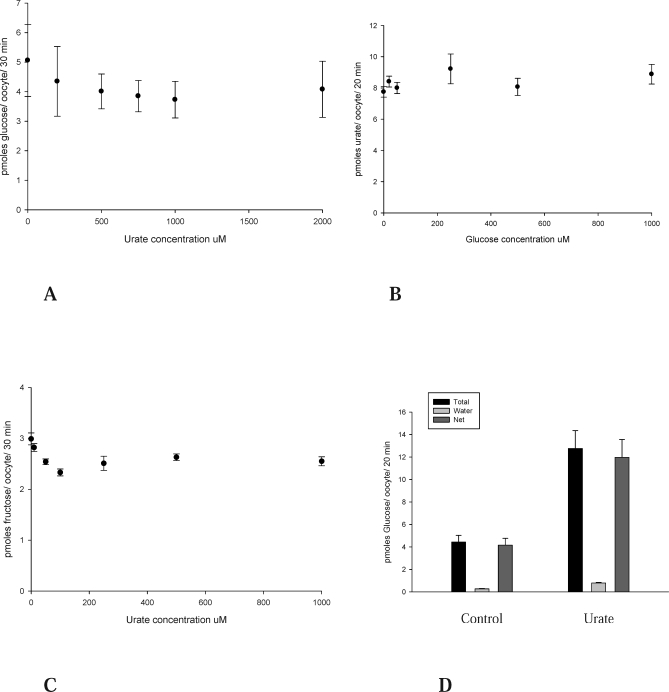
Interaction between Hexoses and Human SLC2A9a-Mediated Urate Uptake in Xenopus OocytesOocytes were injected with SLC2A9a cRNA 4 d prior to uptake experiments. Symbols represent mean net substrate uptake and error bars the SEM for measurements made in 6–10 oocytes per condition. Total uptake of substrates was measured into SLC2A9a cRNA-injected oocytes and then corrected for the uptake measured under identical conditions using water injected oocytes from the same batch of eggs.(A) Uptake over 30 min of 50 μM glucose in the presence of increasing concentrations of urate.(B) Uptake over 20 min of 5 μM urate in the presence of increasing concentrations of glucose.(C) Uptake over 30 min of 50 μM fructose in the presence of increasing concentrations of urate.(D) Human SLC2A9a-mediated glucose and urate exchange. Oocytes injected with SLC2A9a cRNA or water, 4 d prior, were incubated with non-radiolabelled 2 mM L-glucose or 2 mM urate for 1 h. Oocytes were then washed and then incubated at 22 °C for 30 min in 14C-labeled 10 μM D-glucose. Bars represent the average total uptake into 20 eggs expressing SLC2A9a or water-injected eggs, and the difference between the two, the net uptake. Error bars represent the SEM.